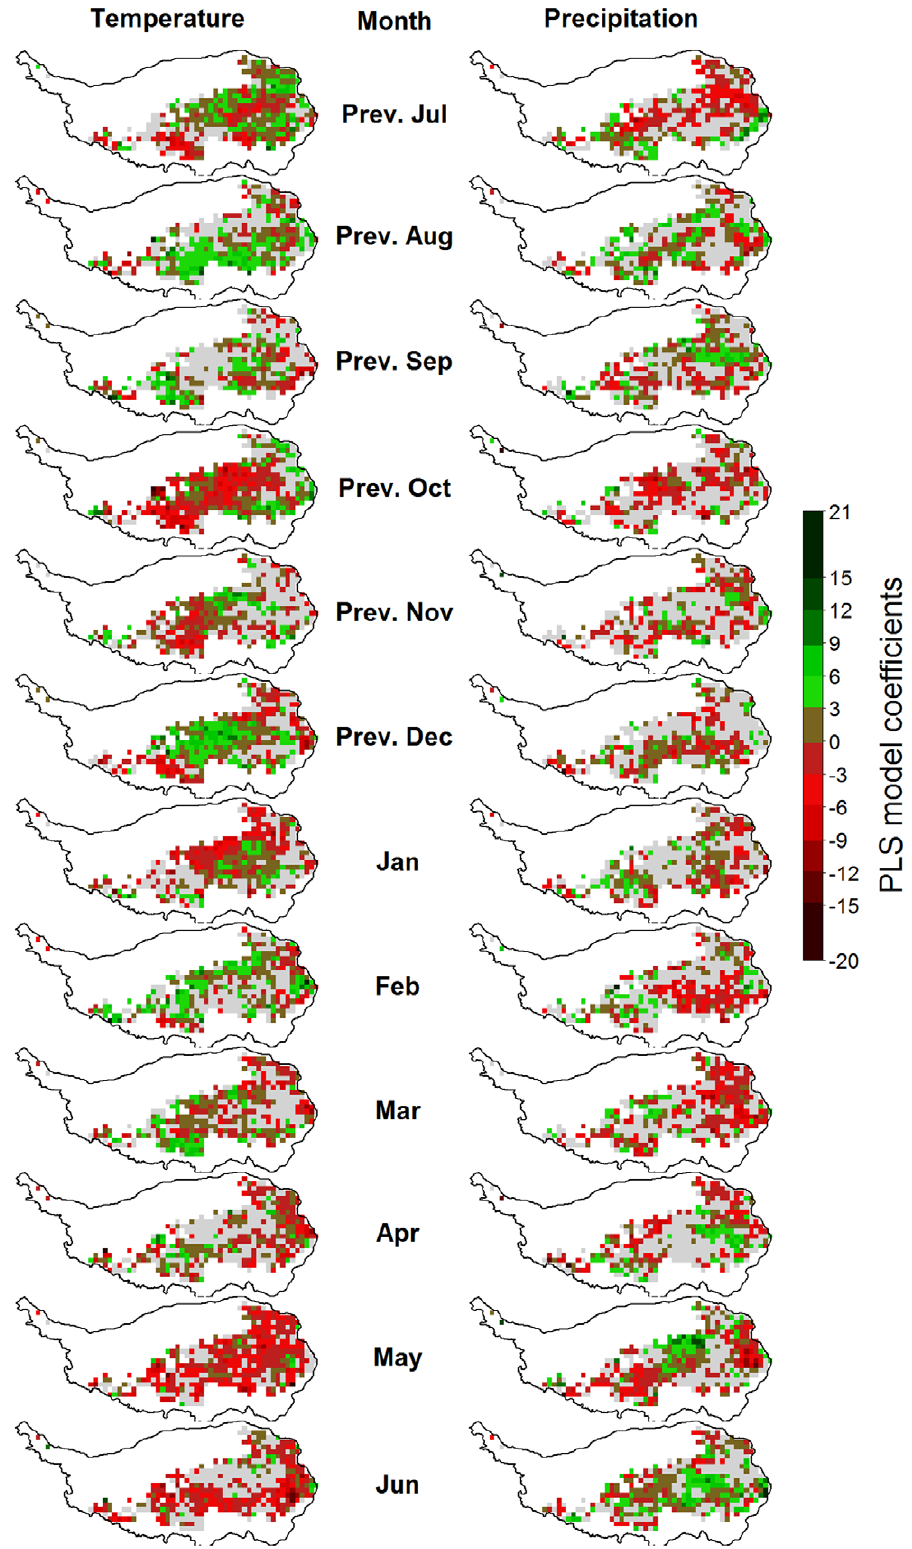
Figure 8. Correlations of monthly temperatures (left) and precipitation (right) with the beginning of the growing season (BGS) on the Tibetan Plateau, according to Partial Least Squares (PLS) regression. For each variable, pixels for which the variable-importance-in-the- projection score was , 0.8 are shown in gray. Pixels with insufficient data for PLS analysis are shown in white.